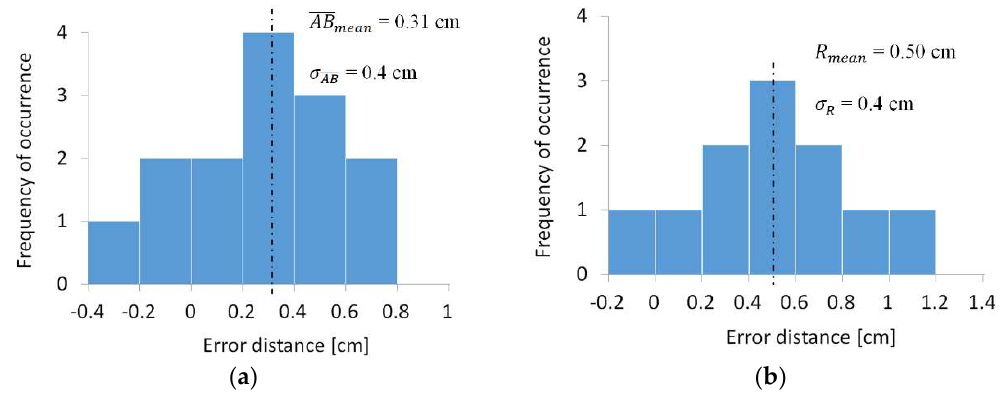
Figure 13. Error in mean distances (cm) and its standard deviation distances (cm) distribution graphs in CG at 15 m: ( a ) pounding upper surface; ( b ) south side of the north-east surveyed arch.